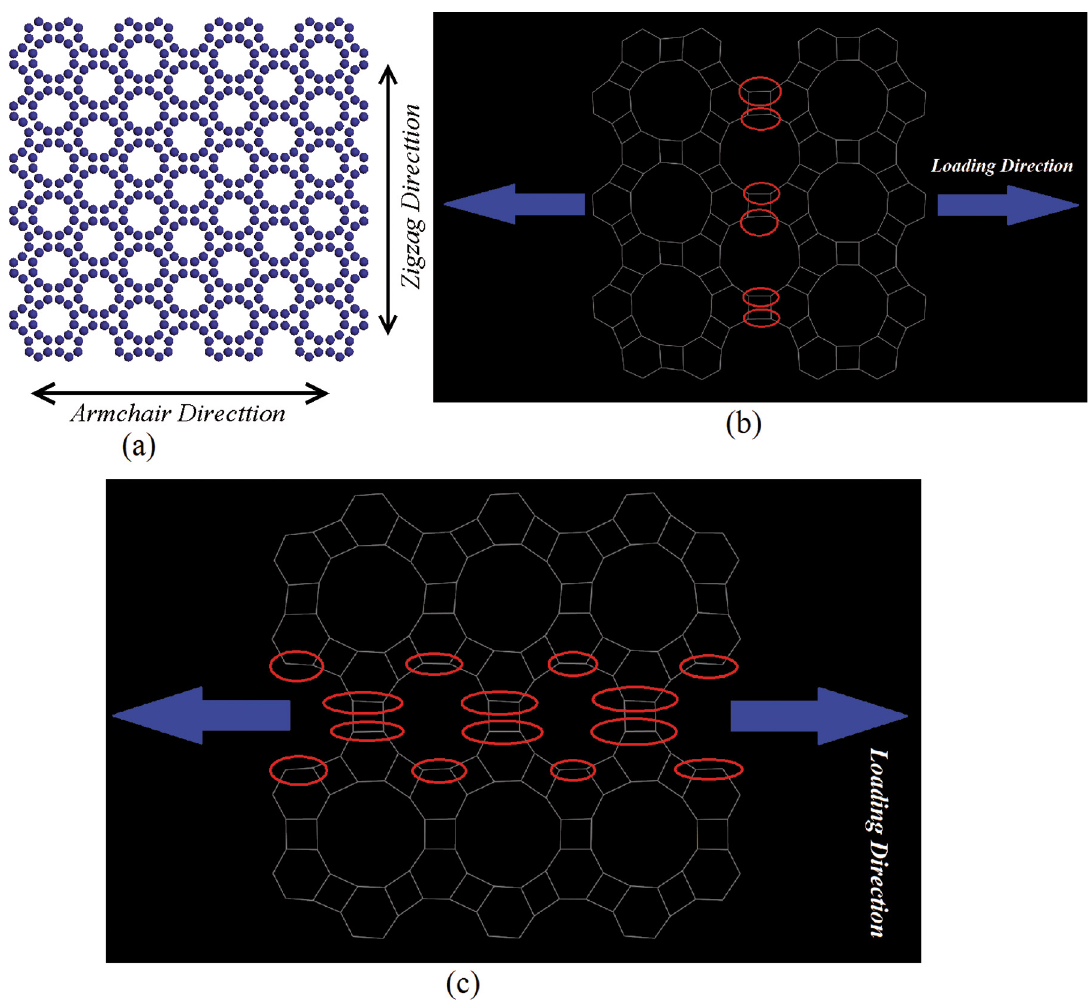
Figure 1: (a) Schematic of graphenylene with the armchair and zigzag direction, (b) Loading direction and C-C bonds detected along the loading direction for armchair and (c) zigzag nanosheets